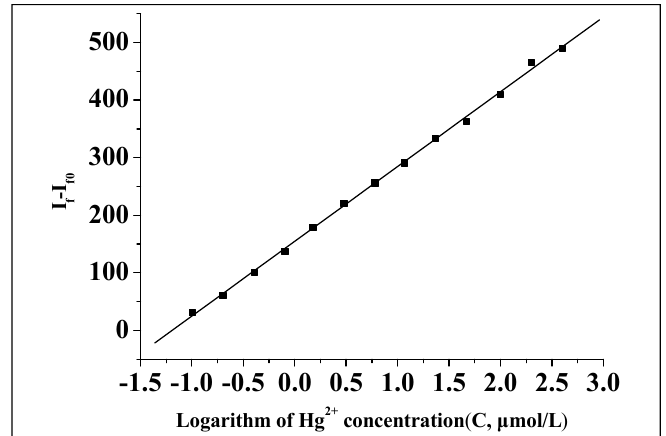
Figure 10. The calibration curve for the determination of Hg(II).